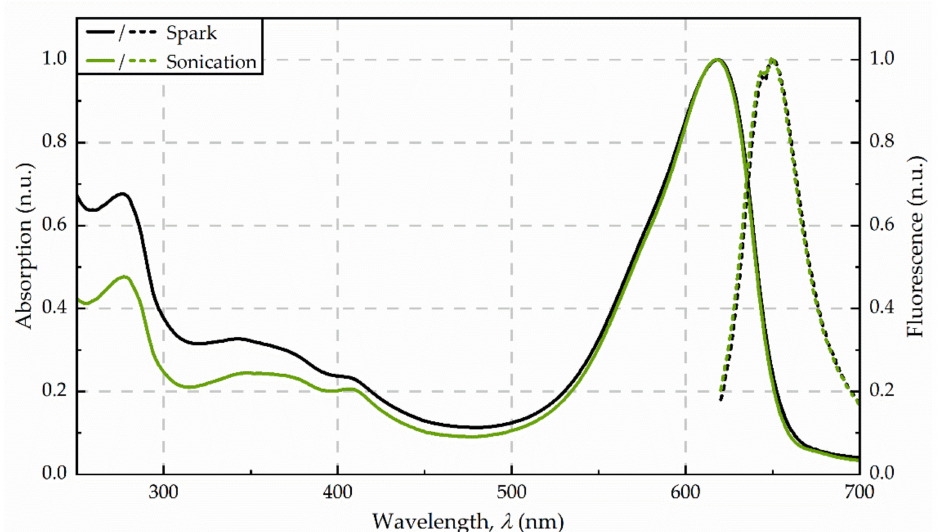
Figure 3. Absorbance (solid line) and fluorescence (dotted line) spectra from the purified extracts, obtained for disintegration by spark discharges and sonication, respectively. Spectra were averaged from three replicates and normalized to 620 nm (absorption) as well as 650 nm